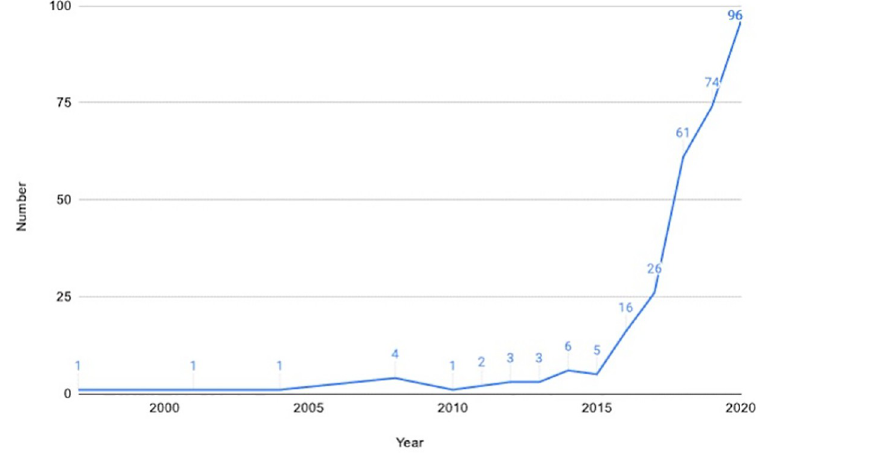
Fig 1. Number of AI/ML-enabled devices by year of FDA decision date. Data extracted from [9].